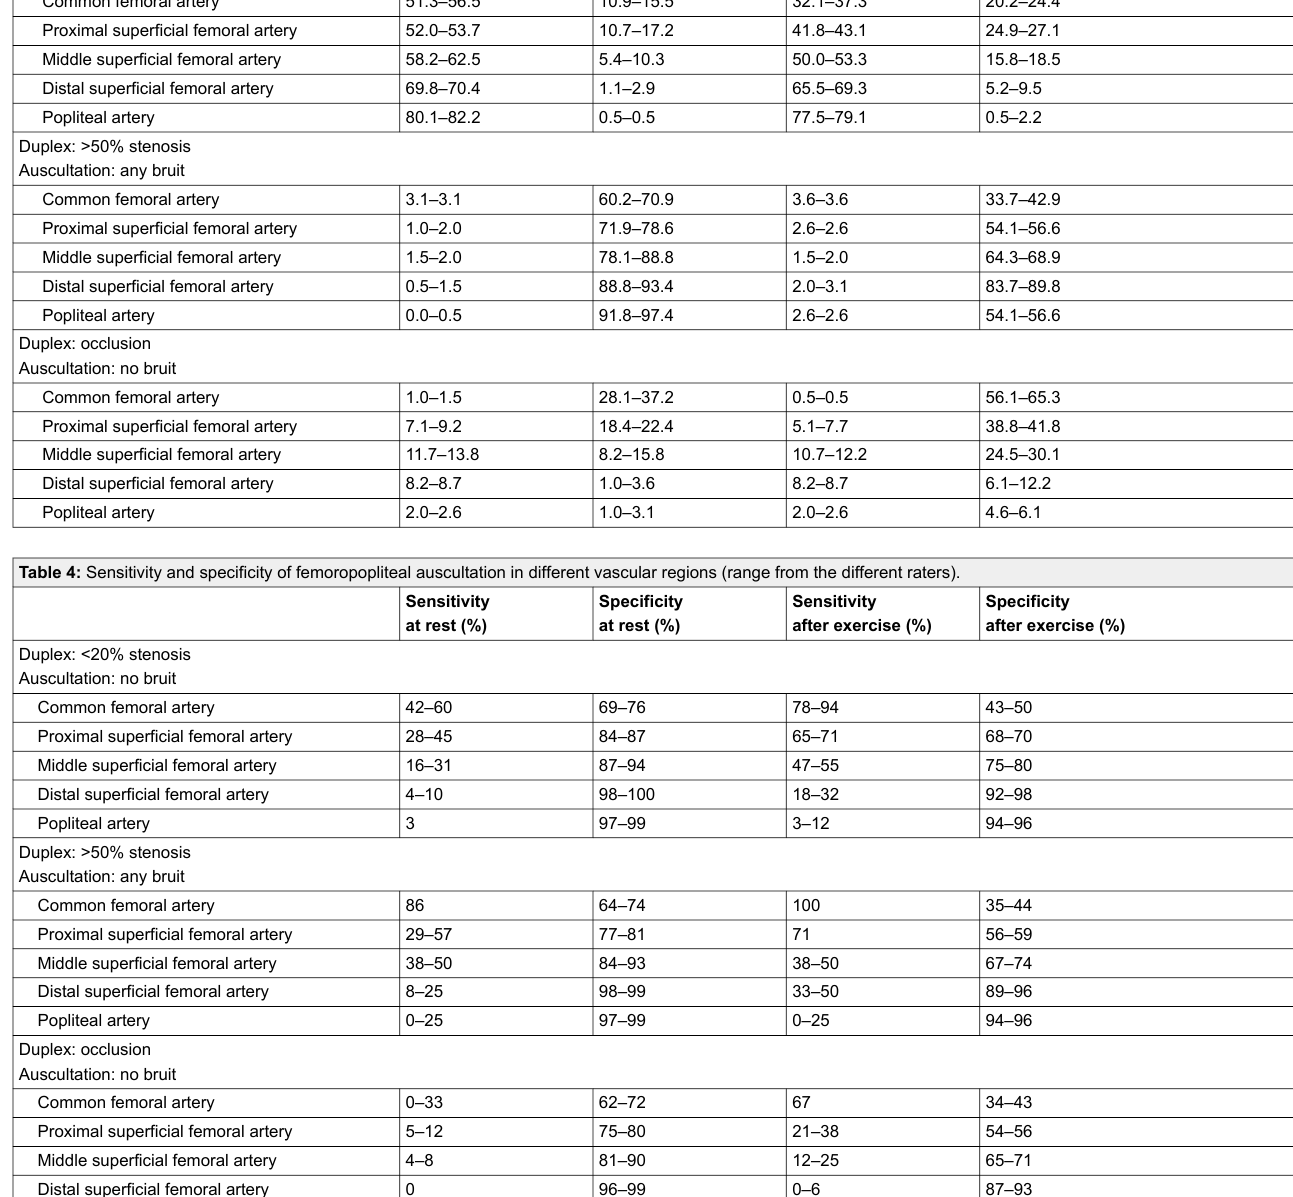
True positive True negative True positive True negative at rest (%) at rest (%) after exercise (%) after exercise (%)